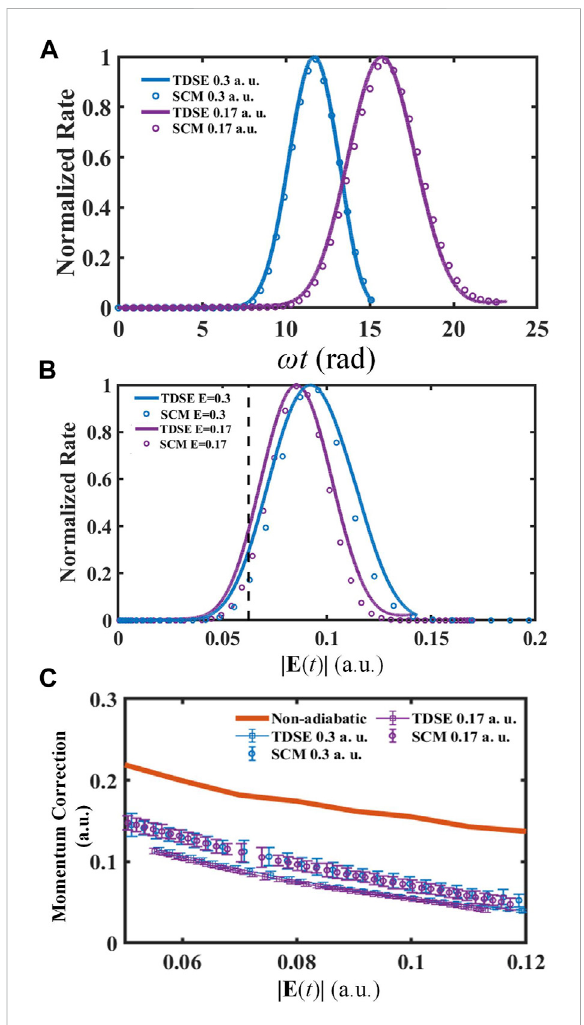
FIGURE 4 The comparisons between TDSE and SCM. (A) The ionization rates normalized by the maximum. The blue and purple lines represent the ionization rates given by TDSE with different peak electric fi eld strengths, 0.3 and 0.17 a.u. The blue and purple circles represent the counterparts in SCM. (B) The same as (A) but the horizontal ordinate is the instantaneous electric fi eld strength in rising edge instead of time. The black dotted line represents the threshold of the OBI regime, E OBI (cid:1) 0 . 0625 a.u. (C) The red line represents the correction of initial transverse momentum deviation from non-adiabatic effect. The bule and purple lines represent the total momentum correction p i + p cc in TDSE, and the blue and purple circles represent the counterparts in